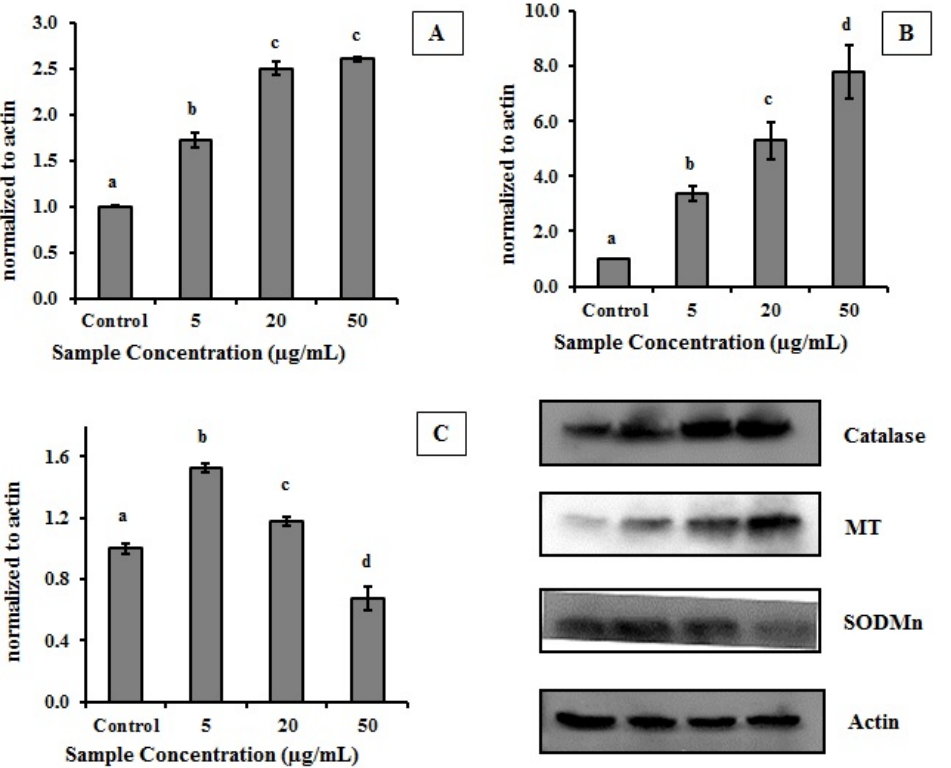
Figure 4. Effect of MEC on level of CAT, SOD and MT in HeLa cells. Graphic represents the relation of protein normalized to actin. ( A ) Catalase enzyme; ( B ) MT—Metallothionein; ( C ) SODMn—Superoxide dismutase. In the upper right are the images of the western blot of proteins involved. Letters a,b,c,d Indicate significantly differences between different concentrations of the same sample. Student-Newman-Keuls test ( p <